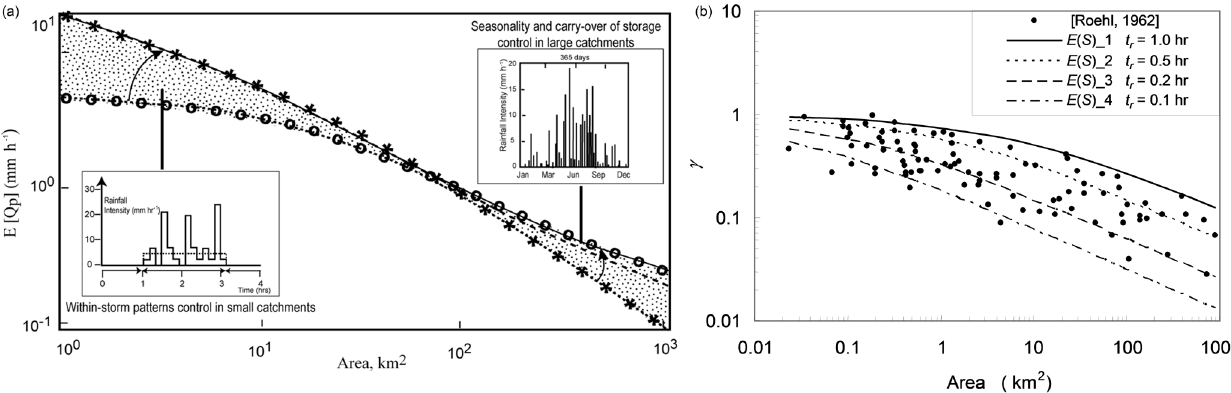
Figure 5. Explaining power-law relationships as emergent phenomena arising from timescale interactions: (a) mean annual flood as a function catchment area, A , in the Appalachian region (taken from Sivapalan, 2005); (b) sediment delivery ratio (SDR) γ as a function of catchment area for different values of rainfall duration t r and an assumed power-law relationship of mean channel travel time t c with A (taken from Lu et al.,